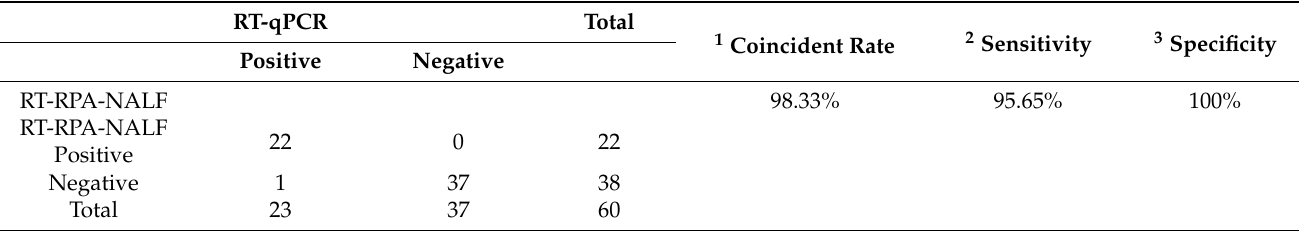
Table 2. Comparison of RT-RPA-NALF and